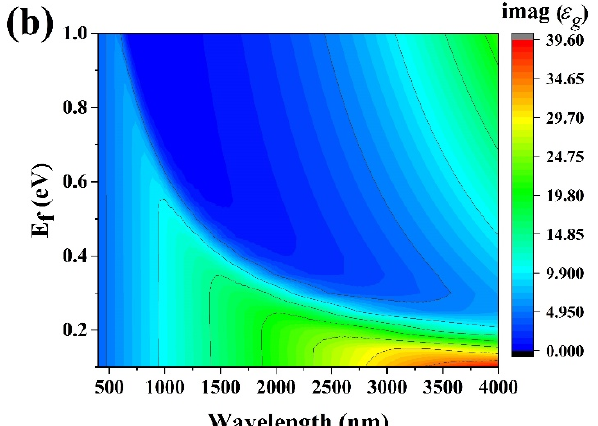
Figure 6. Simulated SLG permittivity as a function of wavelength and Fermi level. ( a ) Real and ( b ) imaginary parts.